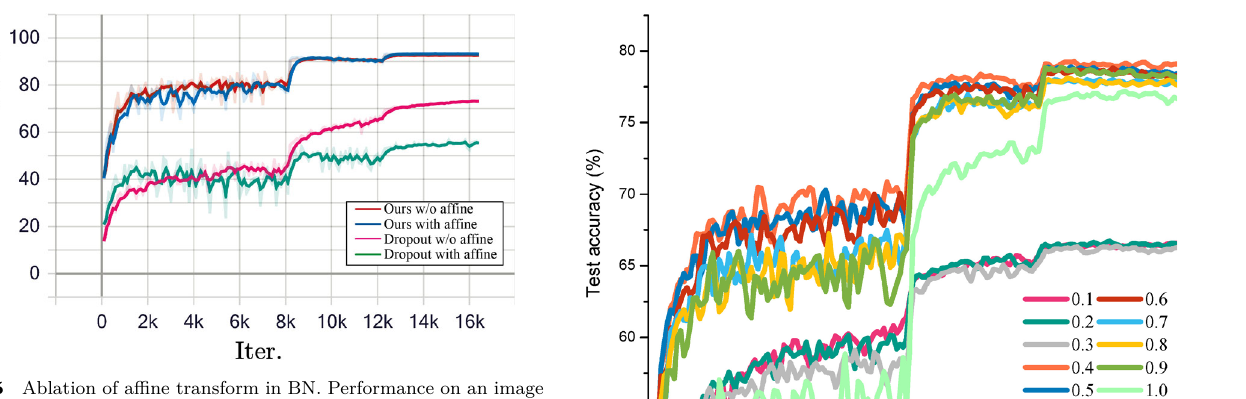
Fig. 5 Ablation of affine transform in BN. Performance on an image recognition task is shown for four different models: WAU and Dropout, each with and without BN affine transform.